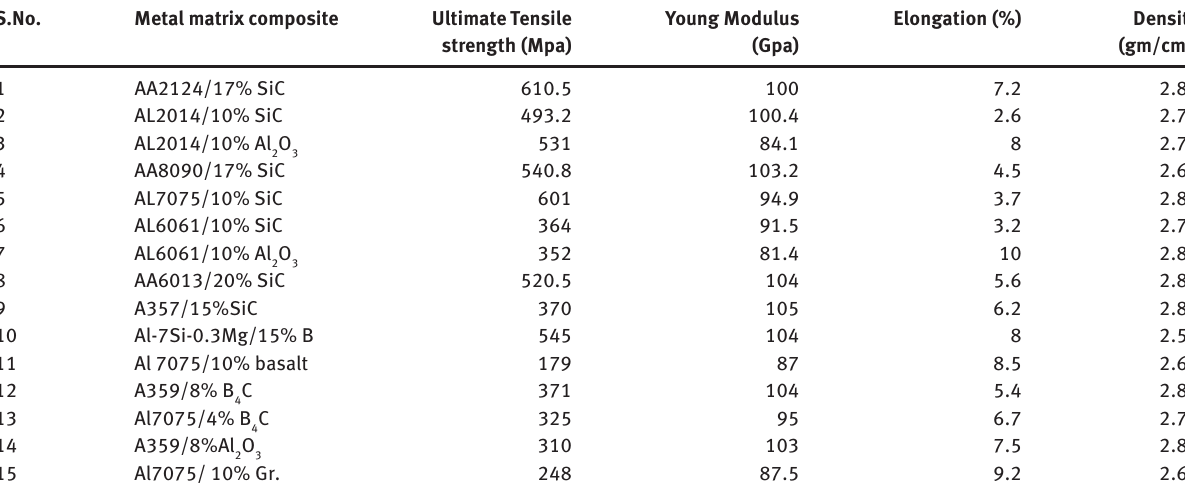
Table 1: Some common MMCs and their mechanical properties. S.No.